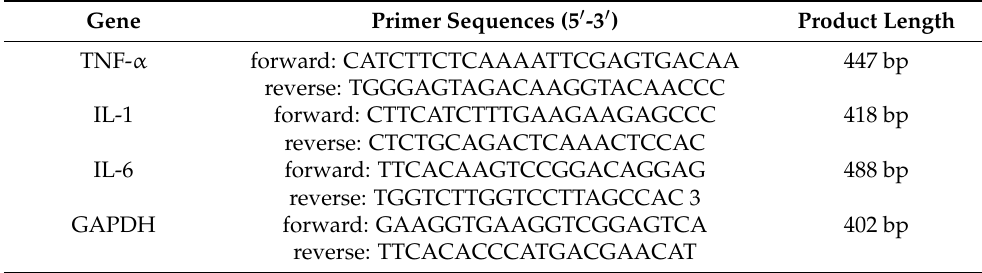
Table 1. PCR primers of mice used in this study.